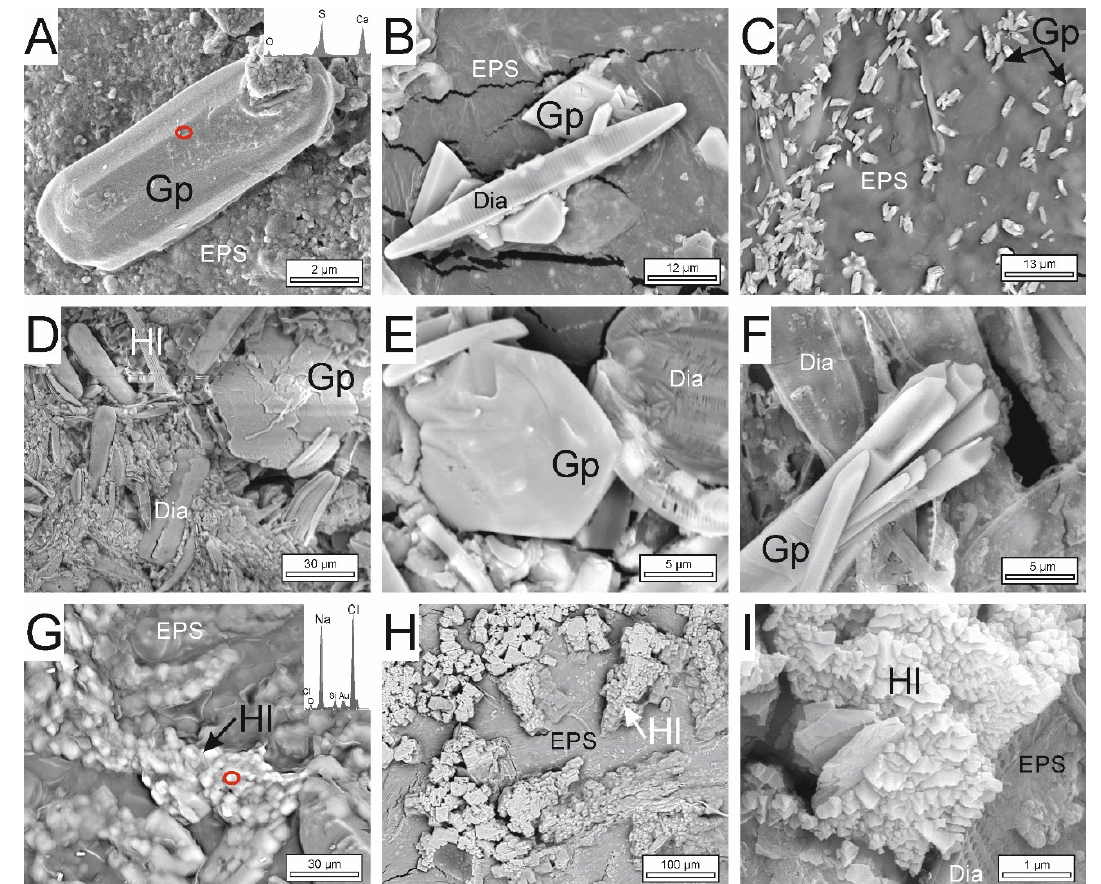
Figure 8 . FE ‐ SEM images of ( A ) coarse ‐ grained and ( B ) fine ‐ grained substrates. Note the exfoliation planes in the parallel lines of gypsum grains in ( A ) (red arrows) and imperfect fractures in ( A , B ) (black arrows).